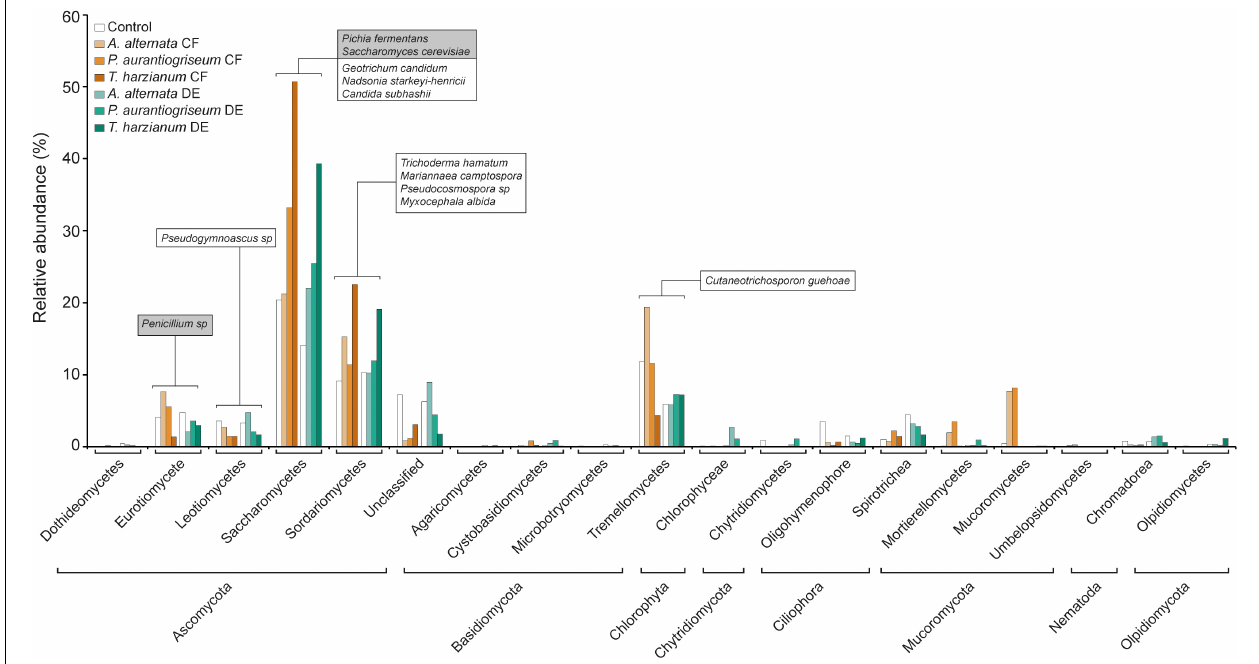
FIGURE 7 | Soil application of fungal CFs and DEs alters the composition of the soil fungal microbiota. The figure shows the relative abundances of fungi in soils irrigated with fungal CFs (highlighted in brown) and DEs (highlighted in green). Relative abundances of fungi in control soils are shown in white bars. Fungi were arranged according to their phylum and class. Species discussed here whose relative abundances are significantly altered by the CF and DE treatments are boxed. Names of species enriched and impoverished by soil application of CFs and DEs are included in white and gray boxes, respectively. Data obtained from Supplementary Table 4